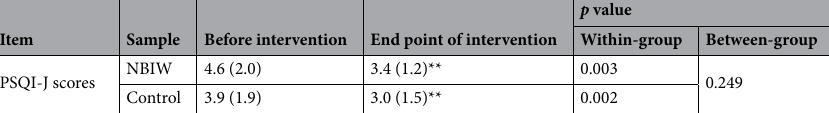
Table 5. Japanese version of Pittsburgh Sleep Quality Index (PSQI-J) scores. NBIW neutral bicarbonate ionized water. NBIW: n = 25, Control: n = 27. Values are shown as mean ( SD ). Within-group comparison: Significant difference compared with before intervention (** p < 0.01: Wilcoxon signed rank test). Between- group comparison: No significant difference between-group (Wilcoxon rank sum